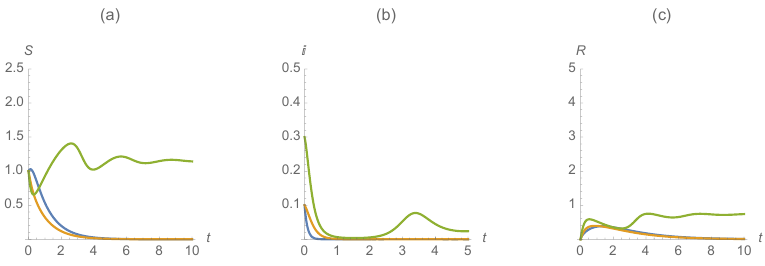
Figure 7. ( a ) S j , ( b ) I j , and ( c ) R j . The first disease is represented in blue, the second in orange and those susceptible/infected/recovered by diseases in green.